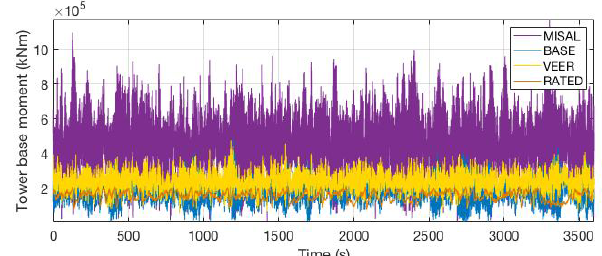
Figure 10. Time series of tower base resultant moment for turbine simulations at a radial position of 12km with rated wind (RATED), baseline wind (BASE), wind with veer (VEER), and misaligned wind